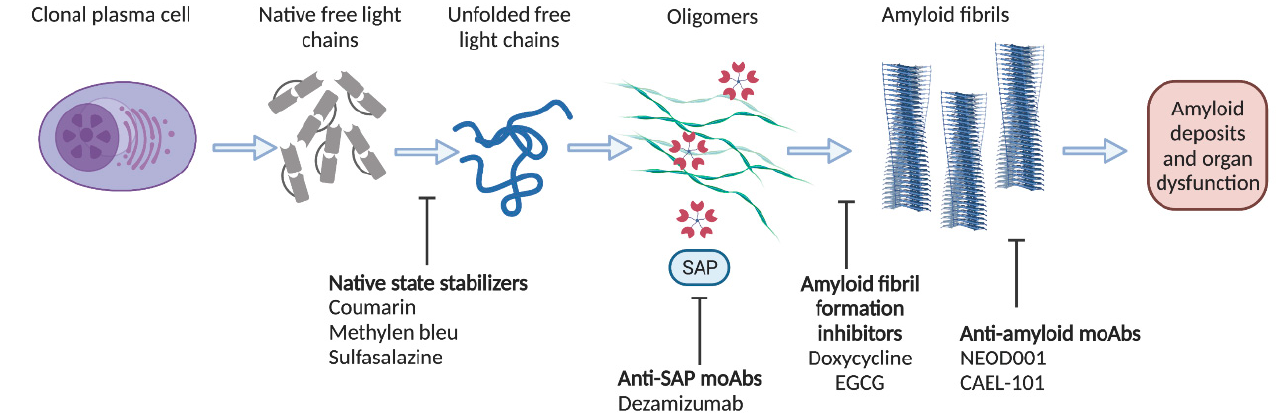
Figure 2. Anti-amyloid targeted therapeutic approaches for AL amyloidosis. Created with BioRender.com (accessed on 10 November